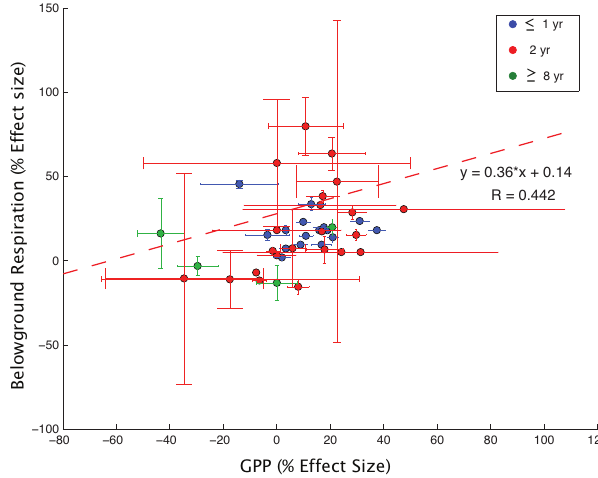
Figure 3. Relationship between GPP and heterotrophic respiration in warmed plots. Data points from the graph also represent the du- ration of warming. Each point represents the effect size expressed as a percentage and the calculated bootstrapped variance (across the x and y